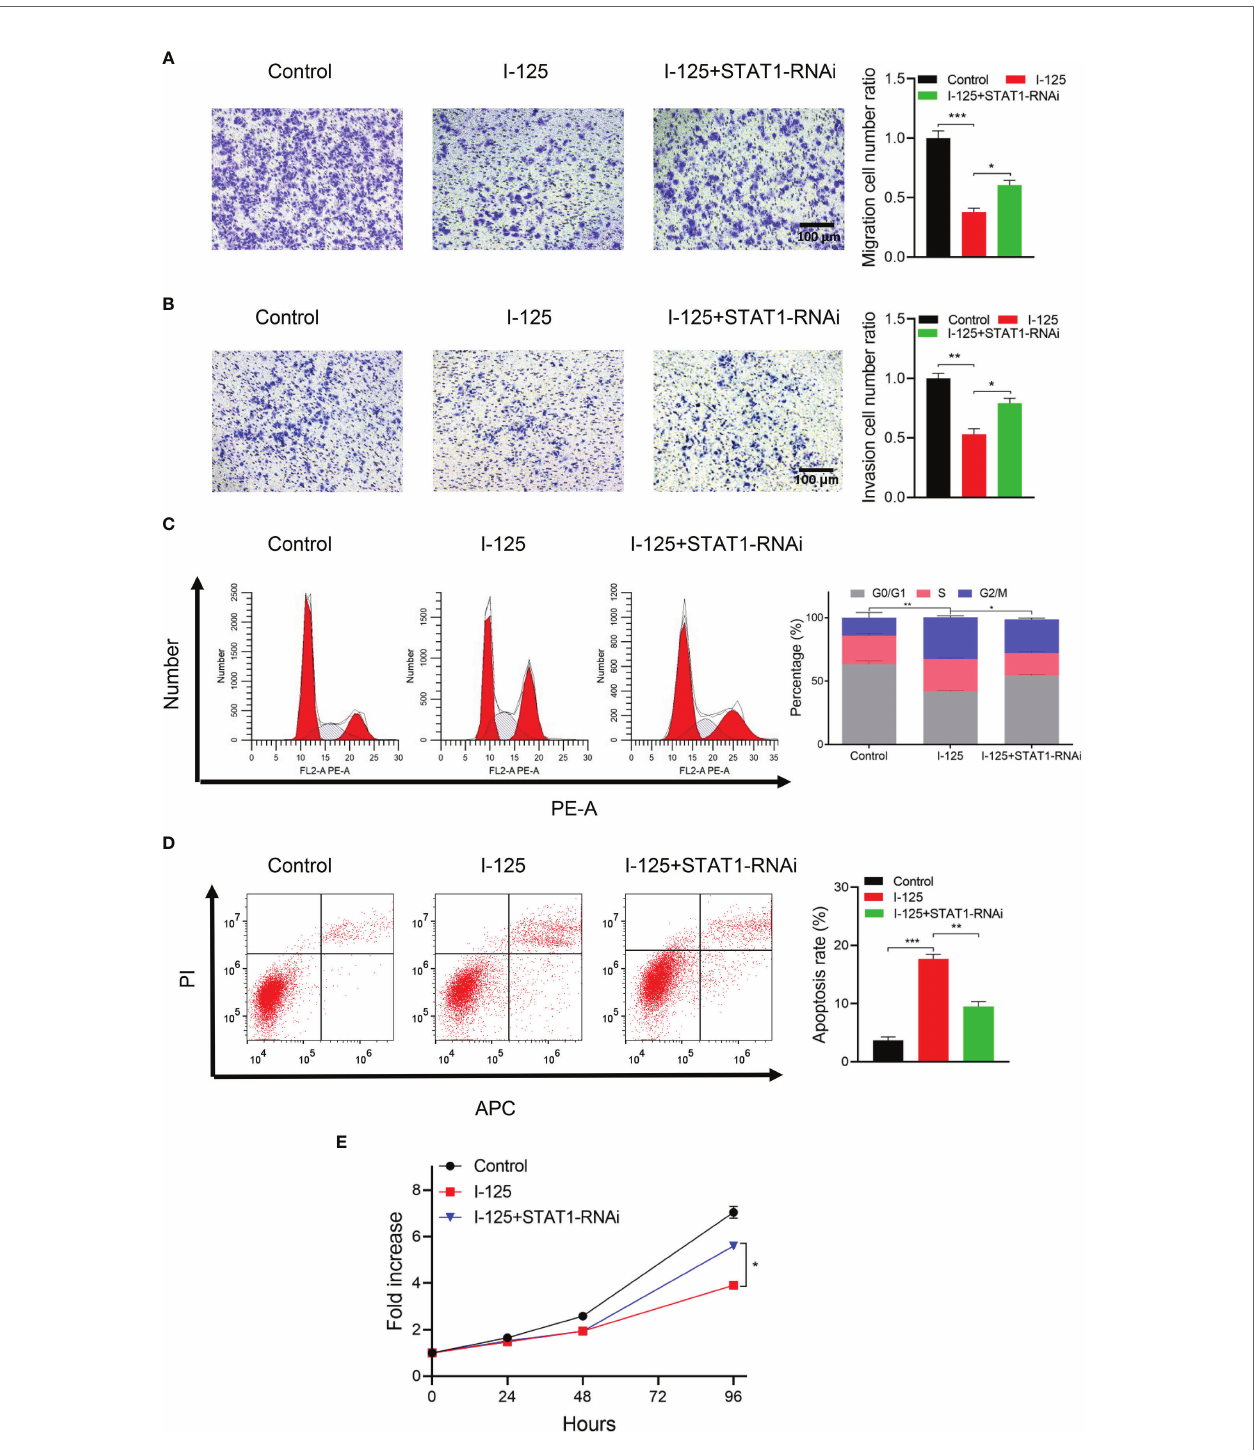
FIGURE 4 | 125 I-induced apoptosis and inhibition of the proliferation of HCC cells via the JAK/STAT1 pathway. (A) Transwell assays showing migration and (B) invasion of SMMC7721 cells transfected with STAT-RNAi. (C) Flow cytometry showing the in fl uence of STAT1 -RNAi on cell proliferation and (D) apoptosis . (E) CCK-8 assay showing HCC cell proliferation. All experiments were performed in triplicate, and the data are presented as the mean ± SD. * P < 0.05, ** P < 0.01, *** P < 0.001. HCC, hepatocellular carcinoma